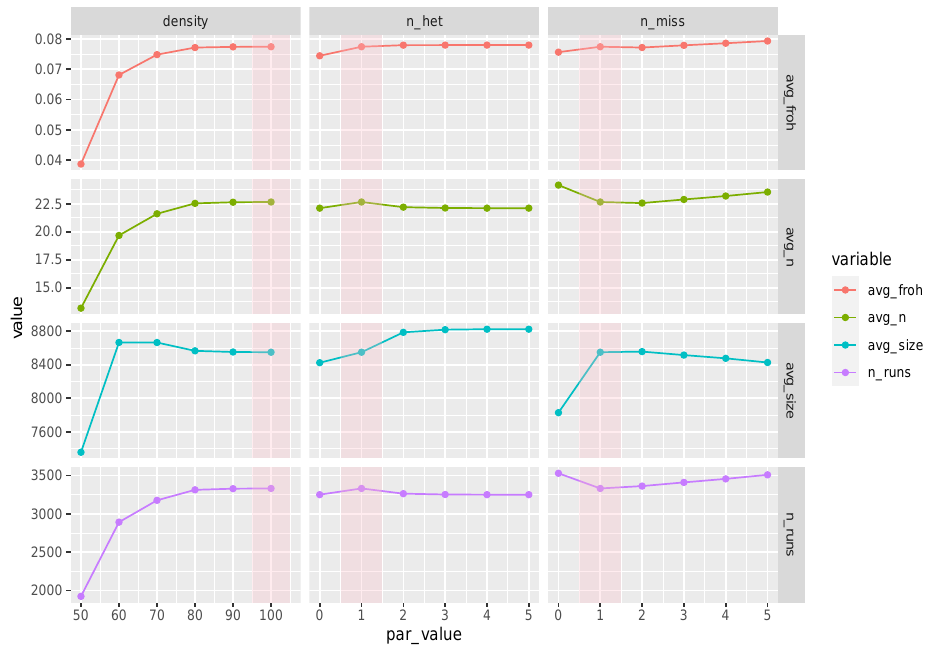
Figure 6. Number of ROH (n_runs), average ROH size (avg_size), average number of ROH per animal (avg_n) and average ROH-based inbreeding (avg_froh) per different values of parameters used to detect ROH in the Maremmana cattle genome: density (1 SNP every n kbps), number of heterozygous genotypes allowed in a ROH (n_het), number of missing genotypes allowed in a ROH (n_miss). The areas shaded in pink highlight the base scenario (density = 100, n_het = 1, n_miss =